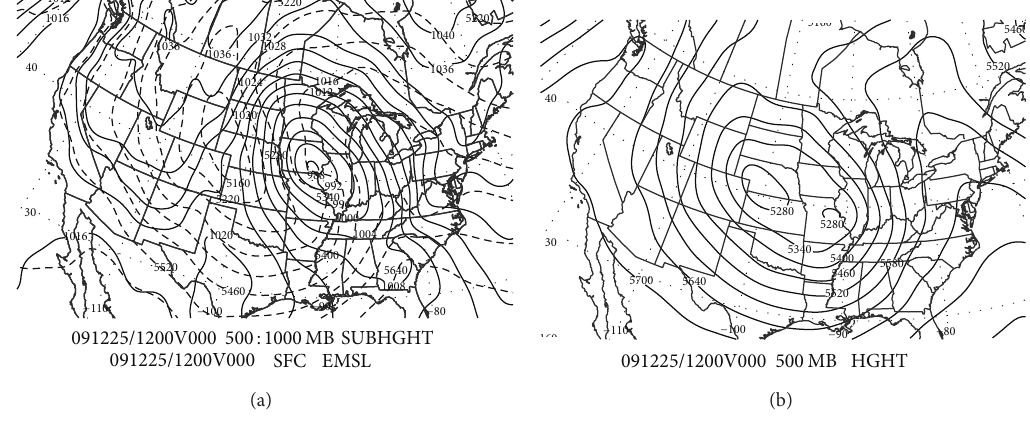
Figure 3: As in Figures 1(a) and 1(b) except for 1200 25 December 2009.